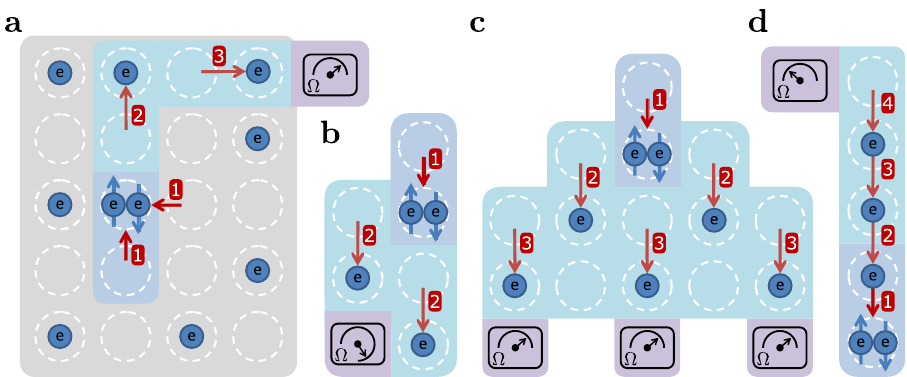
Fig. 4 Cascade-based readout in 2D, fanout and a dense array. Schematic illustrations of cascade-based readout a in a two-dimensional quantum dot array, b using fanout of cascade paths that converge on a single sensor, c for fanout with multiple sensors, and d in a one-dimensional array with each dot occupied by an electron and where the electrons move away from the sensor. Coloured regions indicate the different aspects of the cascade-based spin readout, with the same colour coding as in Fig. 1b. Numbers indicate the order of the transitions. In d , fi rst PSB is performed, then the cascade